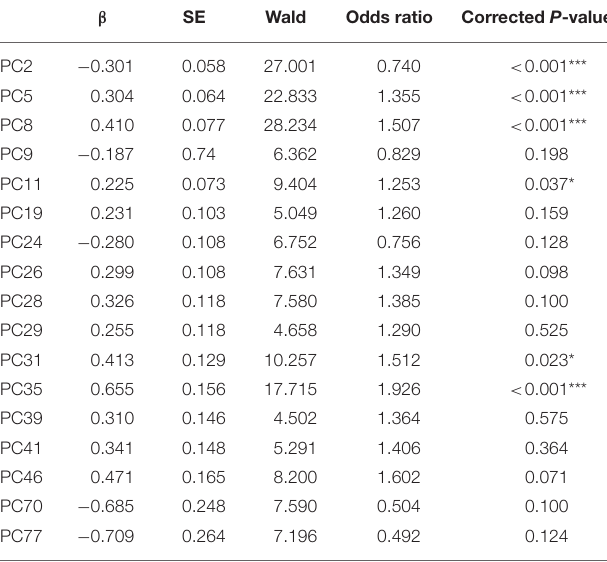
TABLE 4 | Binary logistic regression model of time-domain principal components.